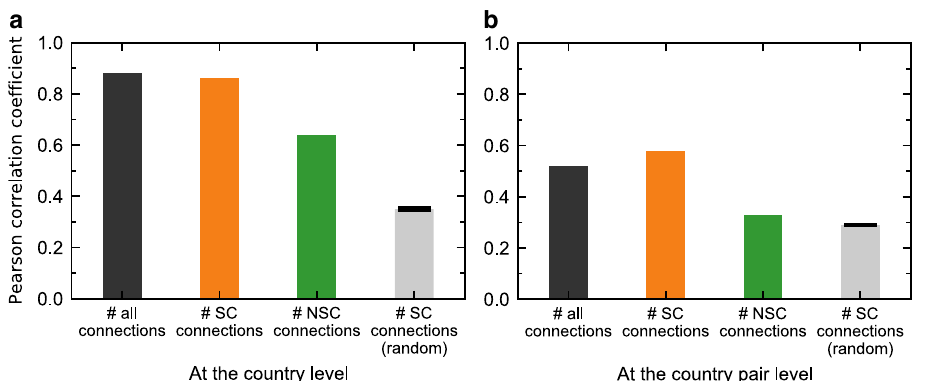
Fig. 9 Correlation between the GLSN topological indicators and international trade indicators of countries. In ( a ), we show for countries the Pearson correlation coef fi cients between international trade value (ITV) and # all (inter-port) connections with all other countries in the world (black bar); between ITV and # SC connections (structural-core connections, those between a country ’ s structural-core ports and ports of other countries), yellow bar; and between ITV and # NSC connections (non-structural-core connections, those between a country ’ s non-structural-core ports and ports of other countries), green bar. In ( b ), we show for country pairs the Pearson correlation coef fi cients between the bilateral trade value (BTV) and # all (inter-port) connections between the two countries (black bar); between BTV and # SC connections (structural-core connections, those with at least one end-node of the connection being a structural-core port), yellow bar; and between BTV and # NSC connections (non-structural-core connections, those with two end- nodes of the connection being both non-structural-core ports), green bar. We test the statistical signi fi cance of the results reported for SC connections (yellow bars), by randomly selecting 1000 sets of ports corresponding in size to the number of ports contained in the structural core (which is 37) and repeating for each random set of ports the same analysis as we did for the detected structural core. Gray bars show the averages of 1000 random cases, and error bars report the standard errors. Source data are provided as a Source Data fi